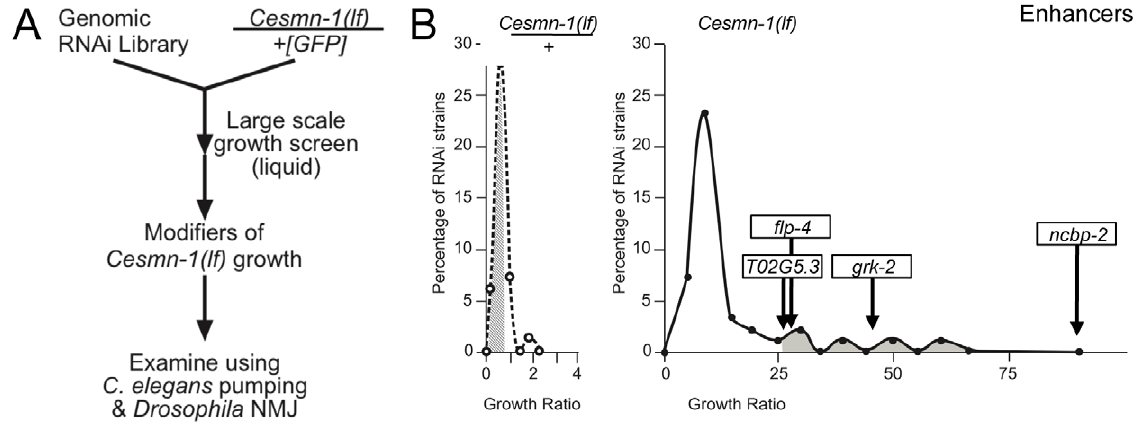
Figure 2. Genome-wide RNAi screen for Cesmn-1(lf) modifier genes. A) To identify genes whose knockdown modifies the growth of Cesmn- 1(lf) animals, the progeny of hT2(lethal)[myo-2p::GFP]/Cesmn-1(lf) ( + /Cesmn-1(lf) , described in text) were reared for more than 2 generations in 96-well, liquid culture format on bacteria expressing dsRNA corresponding to over 16,500 C. elegans genes. Modifier genes identified in this assay were tested subsequently in neuromuscular assays in C. elegans and Drosophila . B) Cesmn-1(lf) and + /Cesmn-1(lf) length was measured for each RNAi clone and a ‘growth’ ratio of large:small animals was determined for each genotype. Representative graphs illustrate the distribution of RNAi clone growth ratios. Candidate enhancer genes were those with a growth ratio more than 2 standard deviations above the mean for Cesmn-1(lf) (shaded in right graph) and within 0.7 standard deviations of the mean for + /Cesmn-1(lf) (shaded in left graph) for each 96-well plate. No suppressors were identified using similar criteria. Two independent determinations were made for each clone in the original screen. Candidate genes were retested in at least quadruplicate and enhanced growth in at least 40% of trials before designation as growth modifier genes; average growth ratios of enhancers from the C. elegans screen are indicated. Cesmn-1(lf) animals, validating the genetic interaction of plst-1 with Cesmn-1 in the neuromuscular pharyngeal pumping assay (Figure 3D). This exacerbation of Cesmn-1 loss of function defects by plst-1 manipulation is consistent with results in other organisms [37]. The ability of Cesmn-1(RNAi) and plst-1(RNAi) to alter pumping of homozygous mutant Cesmn-1(lf) animals suggests that candidate modifier genes can be assessed using RNAi knockdown in this neuromuscular assay.